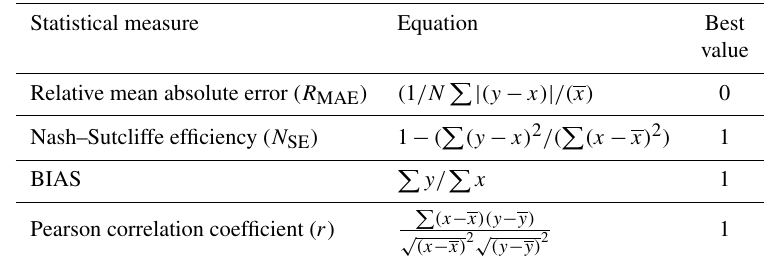
Table 2. Statistical indices for accuracy measurement of satellite rainfall products.